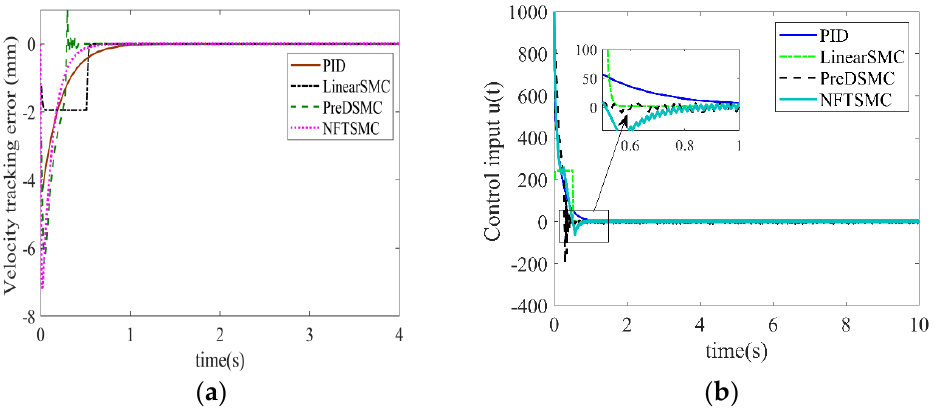
Figure 4. ( a ) Comparison of velocity tracking error for the case of step response of displacement for all control laws. ( b ) Velocity tracking error for the corresponding step tracking of displacement.